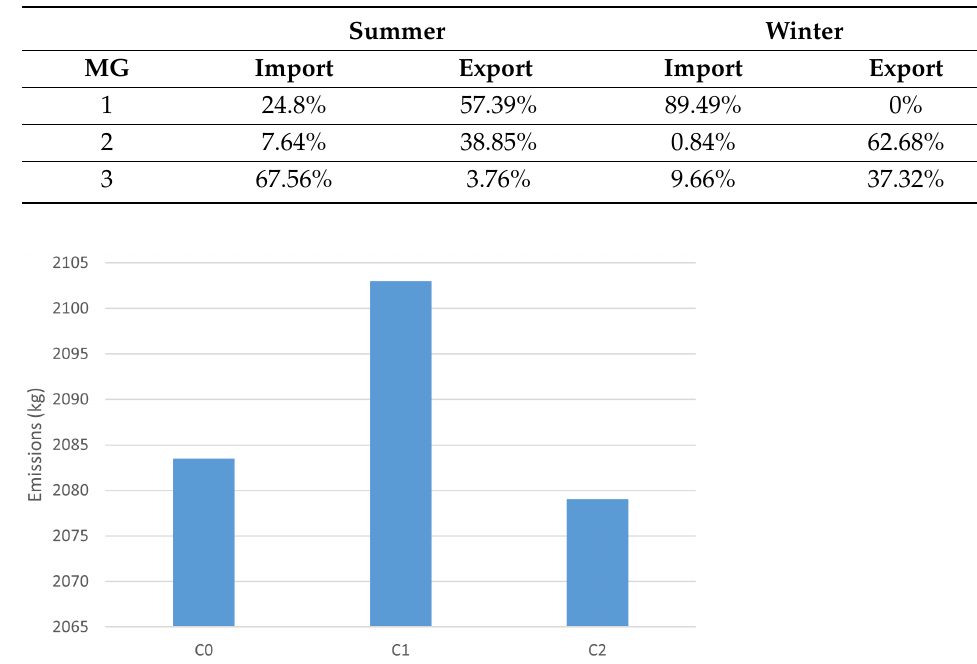
Figure 2. The trades between MGs in C2. Table 3. The ratio of local import and export for each MG in C2.